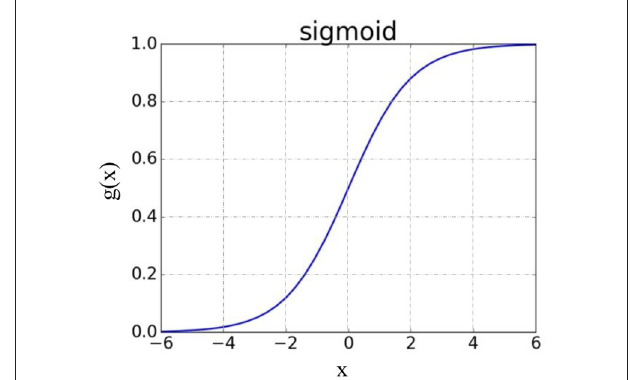
FIGURE 3 | Sigmoid functional